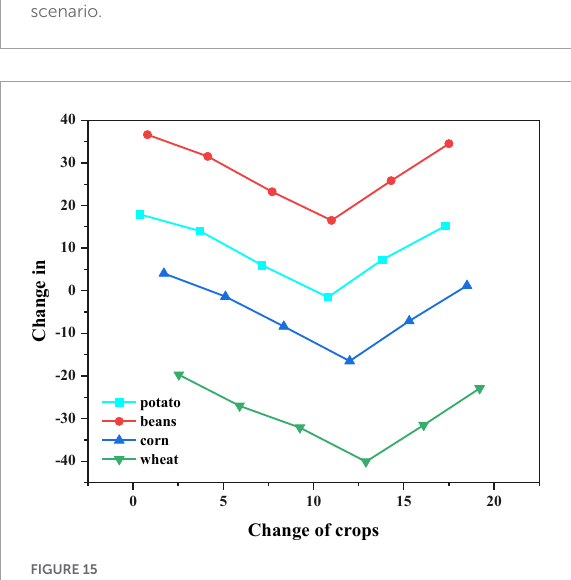
FIGURE14 Absolute value of optimization results under single objective scenario.